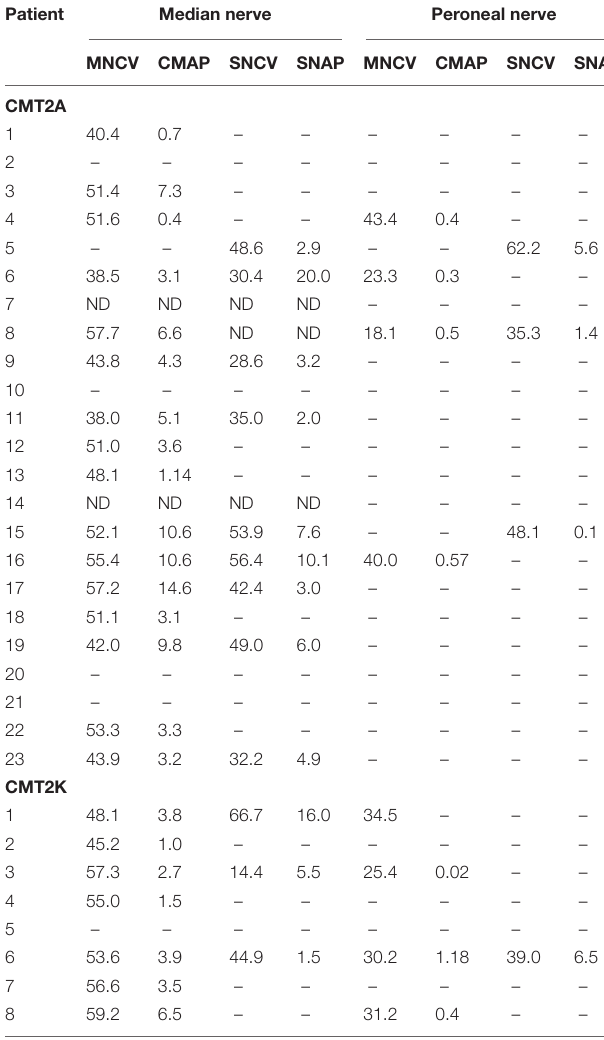
TABLE 2 | Nerve conduction study of the patients with CMT2A and